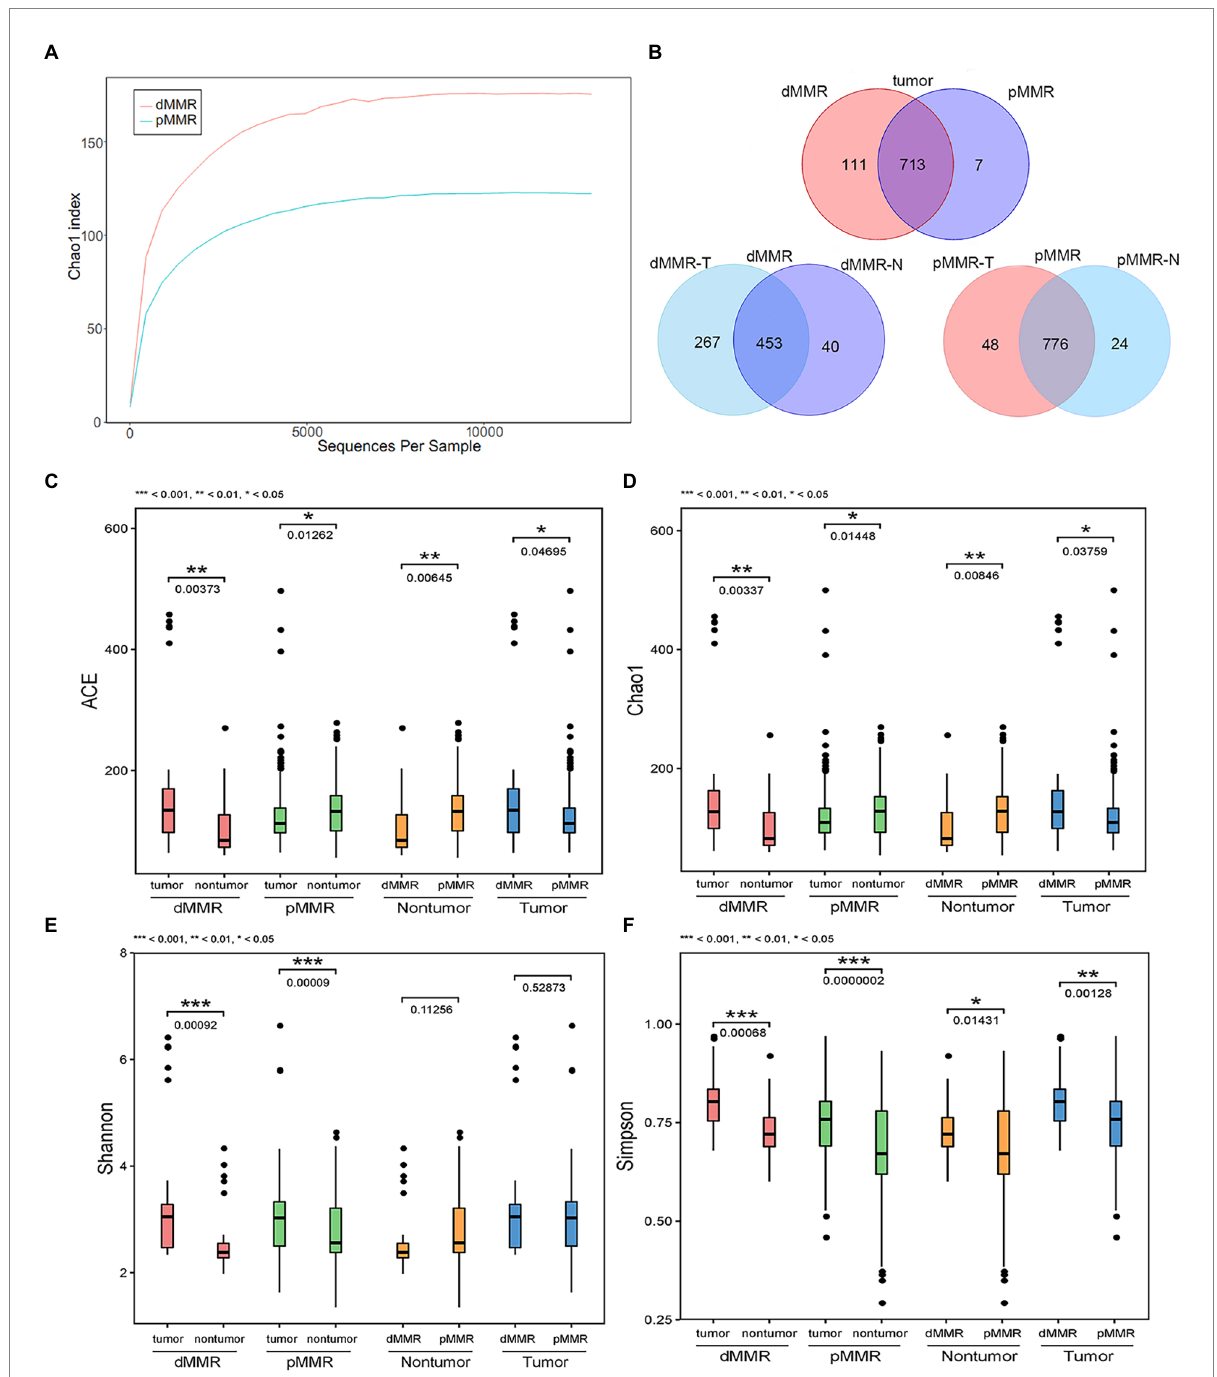
FIGURE 3 Comparative analysis of alpha diversity between dMMR and pMMR groups. The analysis was performed on the 16S rRNA gene sequencing results. (A) Rarefaction curve analysis in the tumor tissue microbiota between dMMR and pMMR. (B) Venn diagram showing the shared OTUs in all plots. ACE diversity plot (C) , Chao1 diversity plot (D) , Shannon diversity plot (E) , and Simpson diversity plot (F) among the dMMR and pMMR groups. dMMR, deficient DNA mismatch repair; pMMR, proficient DNA mismatch repair; dMMR-T, dMMR tumor tissue samples; pMMR-T, pMMR tumor tissue samples; dMMR-N, dMMR normal paracancerous samples; pMMR-N, pMMR normal paracancerous samples. *** <0.001; ** <0.01; *